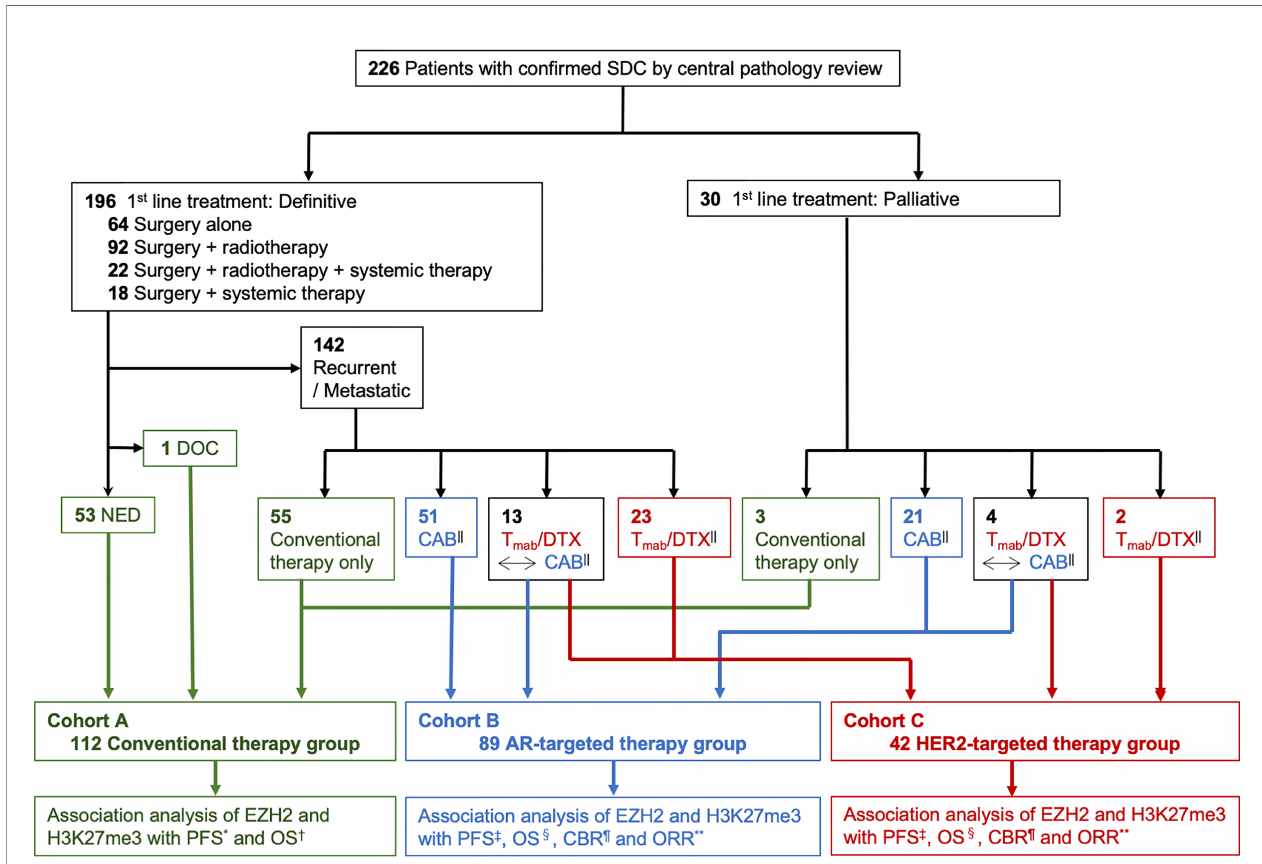
FIGURE 2 | Study fl ow diagram. SDC, salivary duct carcinoma; DOC, dead of other cause; NED, no evidence of disease; Tmab/DTX, trastuzumab and docetaxel; CAB, combined androgen blockade; AR, androgen receptor; HER2, human epidermal growth factor receptor type 2; PFS, progression free survival; OS, overall survival; CBR, clinical bene fi t rate; ORR, objective response rate. * Time from the start of any treatment to the diagnosis of progressive disease. † Time from the start of any treatment to death from any cause or the last follow-up. ‡ Time from the start of AR- or HER2-targeted therapy to the diagnosis of progressive disease or death from any cause. § Time from the start of AR- or HER2-targeted therapy to death from any cause or the last follow-up. || ± conventional therapy. ¶ The percentage of patients who achieved a complete response (CR), partial response (PR) or stable disease for at least 24 weeks. ** The percentage of patients who achieved CR or